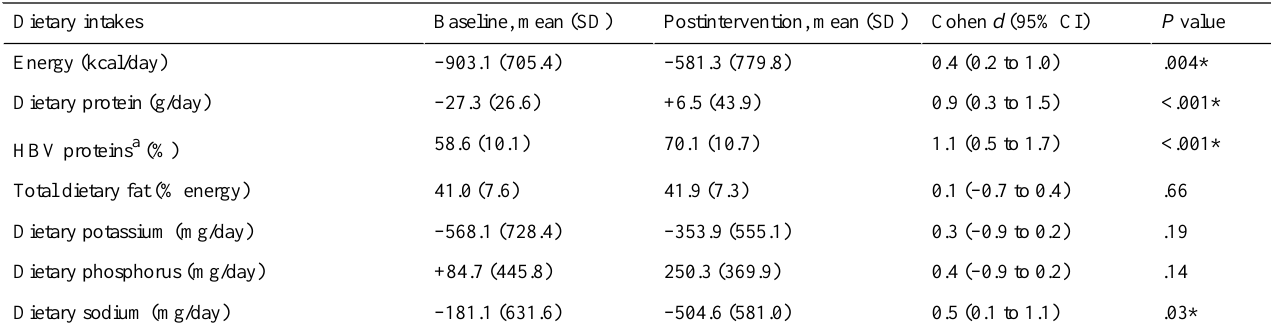
Table 3. Adherence to dietary intakes reported as the difference between intake and recommendation at baseline and